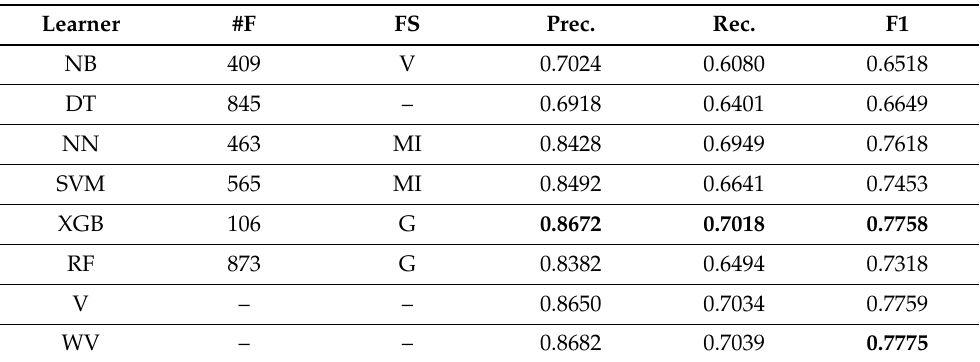
Table 3. Cross validation results with tweet features only, and number of features used (#F). Abbre- viations: Learners—Naive Bayes (NB), Decision Tree (DT), Neural Network (NN), Support Vector Machine (SVM), XGBoost (XGB), Random Forest (RF); Feature Selection (FS), Voting (V), Weighted Voting (WV)—Variance Threshold (V), Recursive Elimination with Mutual Information (MI) and with Gini Index (G). The best results are marked in bold.